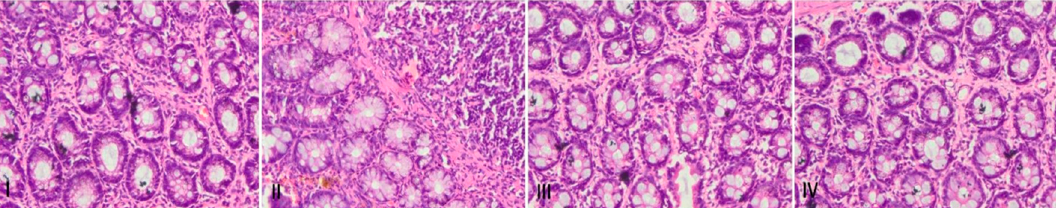
Figure 11. Effect of Piperine treatment on DMH-administered pathological changes in rat colon tissues. Photomicrographs of H&E staining of histological sections of colon tissue depicting different experimental groups: group-I indicate normal histo-architecture of colon sections. Group-II shows extensive disintegration of normal architecture in DMH administered group. In groups III and IV piperine treatment showed protection against piperine-induced pathological changes. Both the doses of piperine maintained the integrity of mucous membrane, goblet cells and colonic crypts ( n = 10), magnification: 40×.